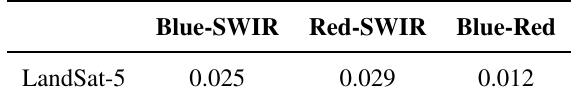
Table 4. RMS errors in reflectance units for regressions (Equations